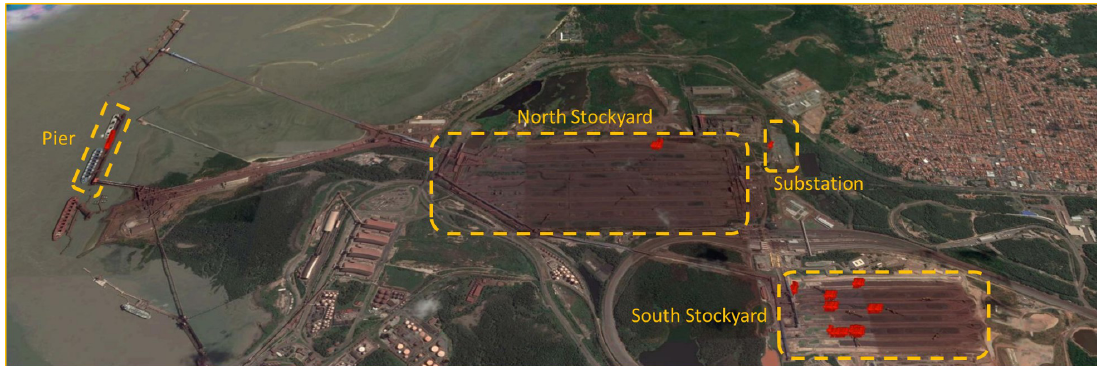
Figure 5. Overview of the test area with the Sensing Platform.